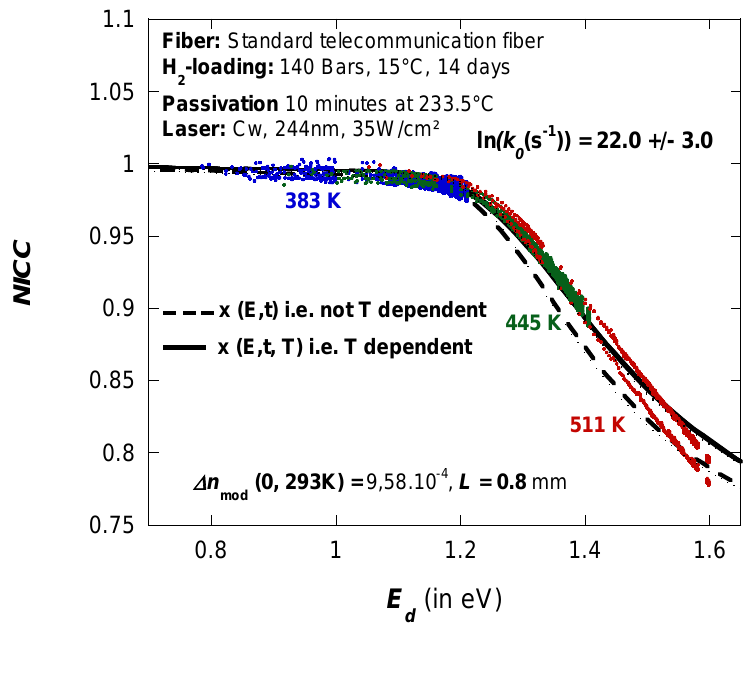
Figure 8. Normalized Integrated Coupling Constant (NICC ) as a function of the = k T .ln( k t ) (in eV), i.e. , the master curve for passivated FBG demarcation energy E d B 0 written in H -loaded germanosilicate core optical fibers. The black lines correspond to the 2 MC prediction based on non-passivated gratings using a non-temperature dependent ( black dotted line ) and a temperature dependent ( black full line )